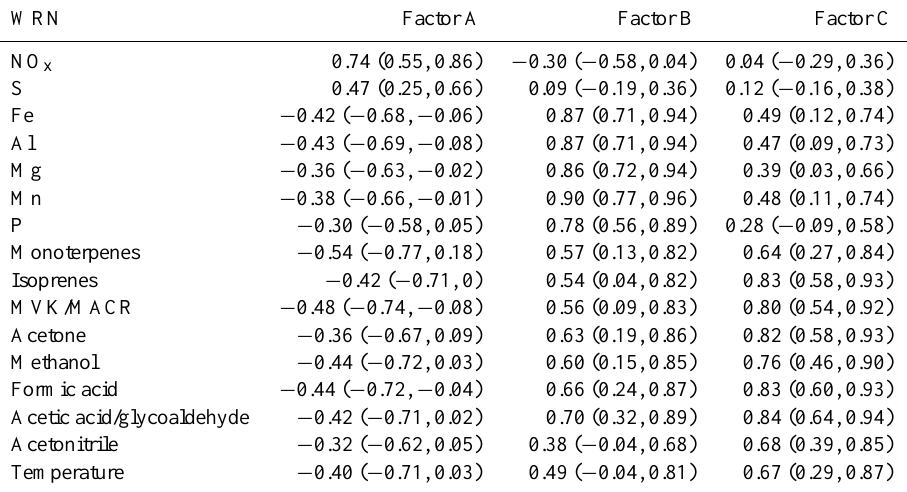
Table 1b. r coefficients between the three PMF factors and tracers at Raven’s Nest. All elements, gases, and parameters in the first column have been averaged over the same time intervals as the filters were sampled over ∼ 24h, making up 36 points. The numbers within the brackets represent 90% confidence intervals (see Table